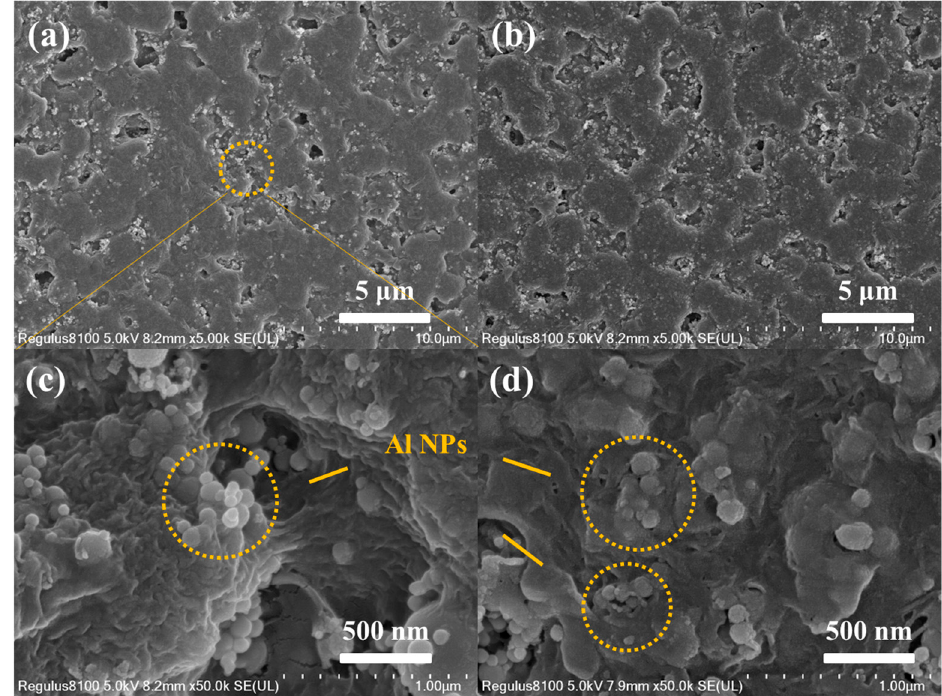
Fire 2023 , 6 , x FOR PEER REVIEW Figure 2. Top ‐ view SEM images at different magnifications of ( a , c ) AP, ( b , d ) APA ‐ 6. Figure 2. Top-view SEM images at different magnifications of ( a , c ) AP, ( b , d ) APA-6.